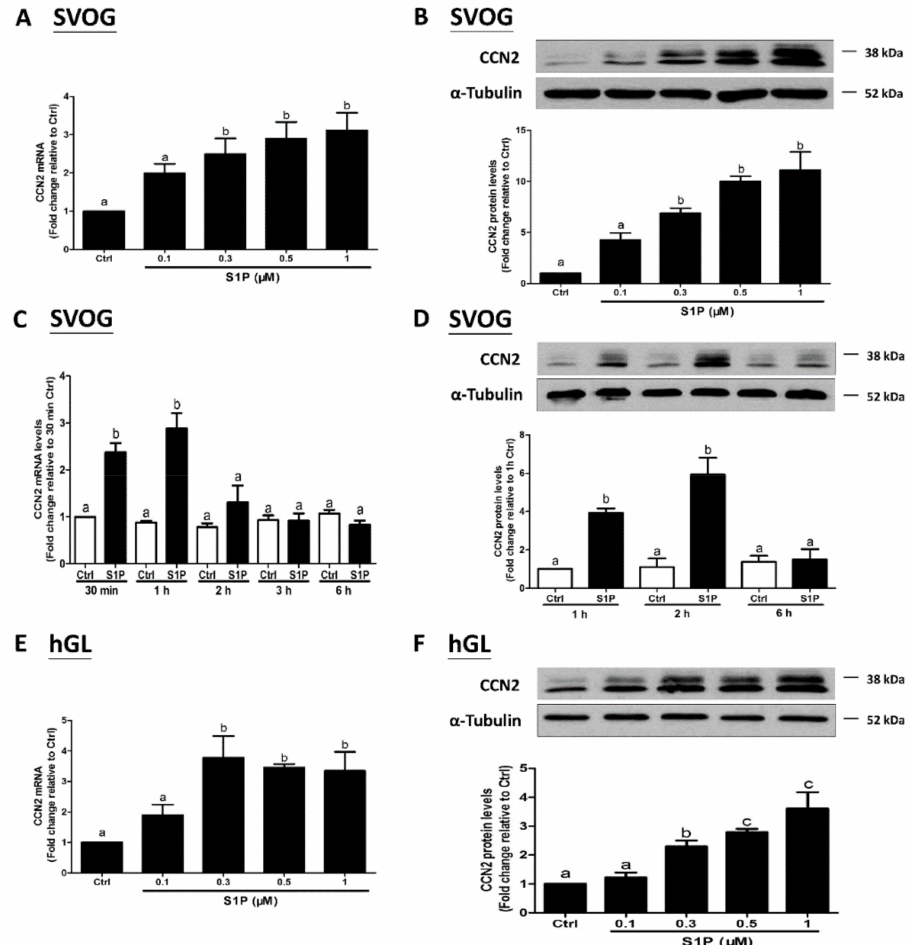
Figure 2. S1P induces the expression of CCN2 in human granulosa-lutein cells. SVOG cells were treated with a vehicle control or increasing concentrations (0.1, 0.3, 0.5, and 1 µ M) of S1P for 1 h ( A ) or 2 h ( B ). The mRNA ( A ) and protein ( B ) levels of CCN2 were examined using RT-qPCR ( A ) and western blot analysis ( B ), respectively. SVOG cells were treated with a vehicle control or 0.3 µ M S1P for various periods of time (30 min, 1 h, 2 h, 3 h, or 6 h); the mRNA ( C ) and protein ( D ) levels of CCN2 were examined using RT-qPCR ( C ) and western blot analysis ( D ), respectively. Primary human granulosa-lutein (hGL) cells were treated with a vehicle control or increasing concentrations (0.1, 0.3, 0.5, or 1 µ M) of S1P for 1 h ( E ) or 2 h ( F ). The mRNA ( E ) and protein ( F ) levels of CCN2 were examined using RT-qPCR ( E ) and western blot analysis ( F ), respectively. The results are presented as the mean ± SEM of at least three independent experiments. If a pair of values is significantly di ff erent ( p < 0.05), the values have di ff erent subscript letters (a vs. b or b vs. c) assigned to